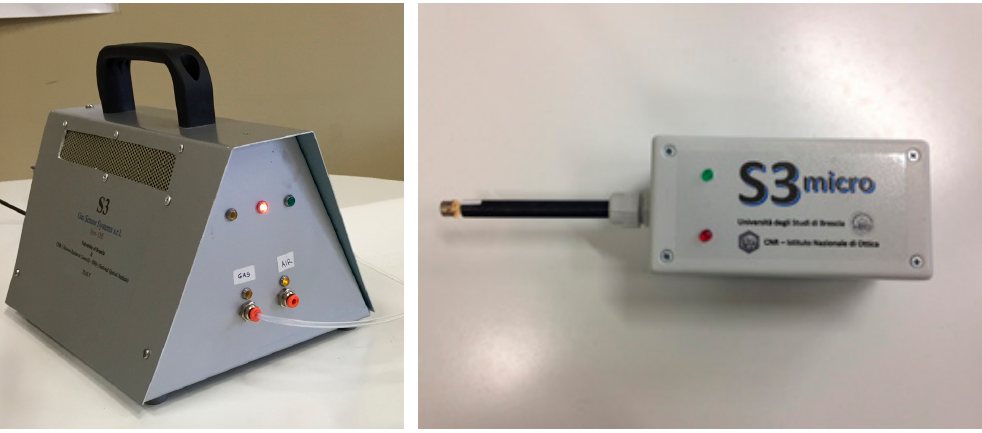
Figure 14. Images of S3-mini ( left ) and S3-micro ( right ) developed by SENSOR Lab (courtesy of NASYS SRL).